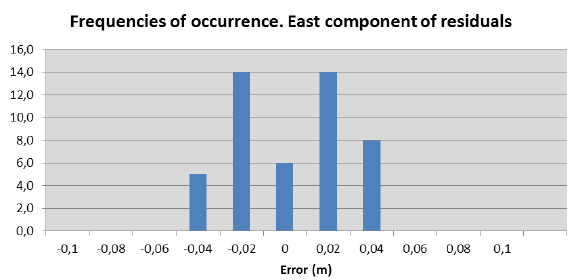
Figure 21. Frequency histogram of the deviations in East component of natural control points positions.